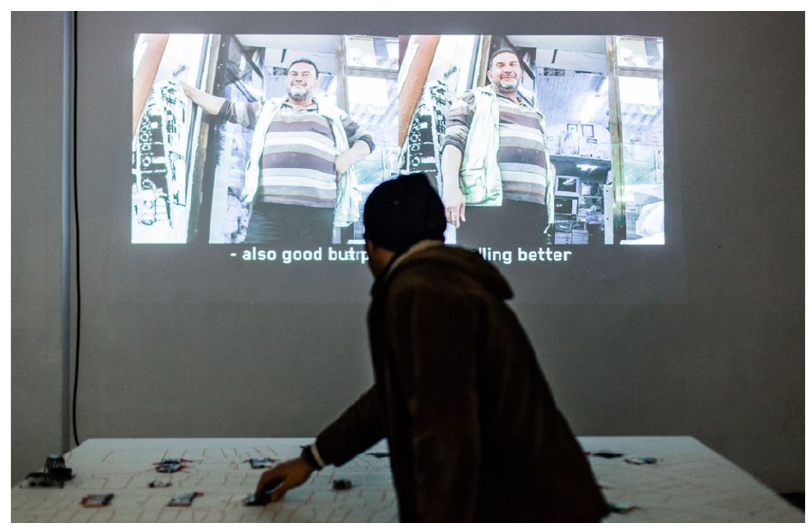
Exhibition of PASAJ “61 meters of Kahya Bey Street” at Apartment Project Berlin, October 2015, photo David